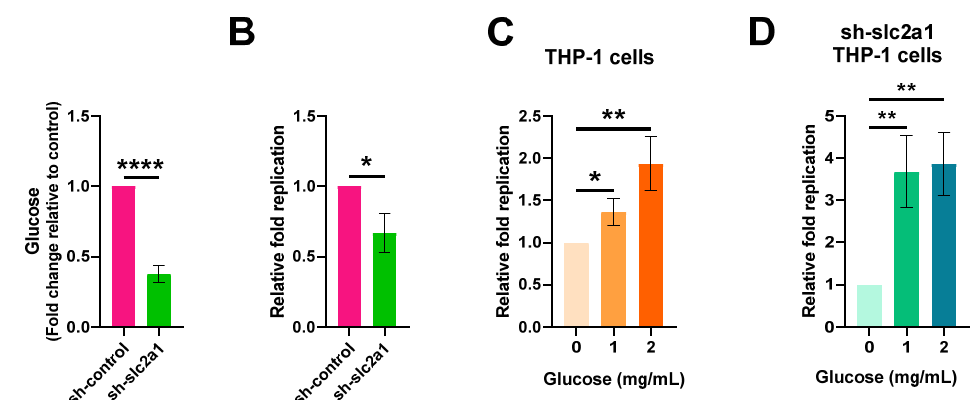
Figure 5. Increased macrophage glucose levels contribute to intracellular replication of S. enterica serovar Typhi ( S. Typhi). sh- slc2a1 represents treatment with lentiviral short hairpin RNA (shRNA) to reduce intracellular glucose levels in human macrophage cell line THP-1 ( A ) Glucose levels of sh- slc2a1 and sh-control-treated THP-1 cells. ( B ) Replication of S . Typhi in sh- slc2a1 or sh-control-treated THP-1 cells. ( C ) Replication of S . Typhi in the presence of 0 mg/mL, 1 mg/mL, or 2 mg/mL glucose, in THP-1 cells. ( D ) Replication of S . Typhi in the presence of 0 mg/mL, 1 mg/mL, or 2 mg/mL glucose, in sh- slc2a1 treated THP-1 cells. ( A – D ) Data were obtained from three independent experiments and analyzed using Student’s t -test. * p < 0.05; ** p < 0.01; **** p < 0.0001.